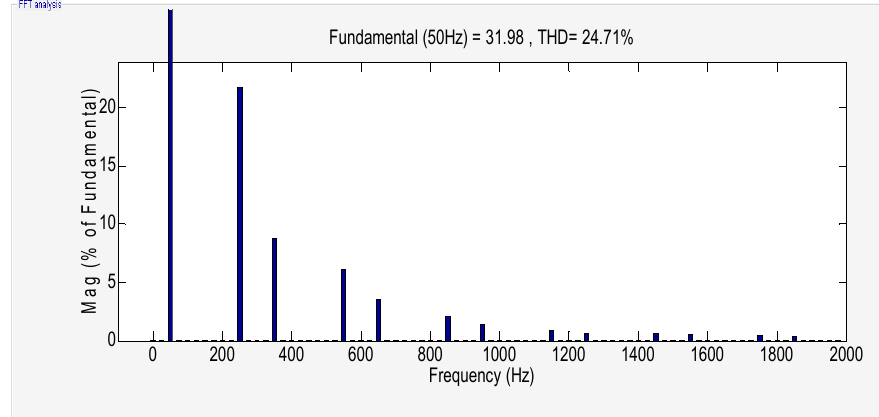
Figure 8. Harmonic spectrum of the source current at 0 s.